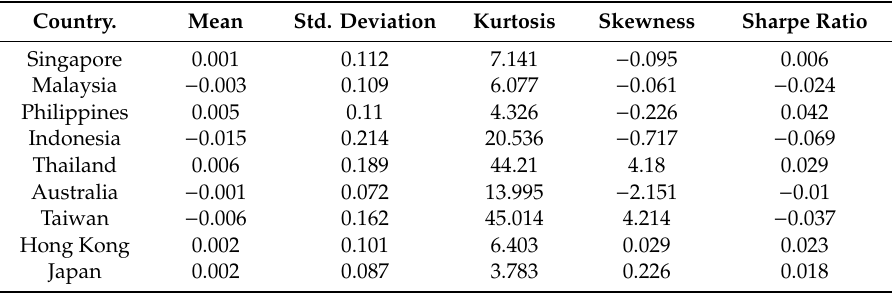
Table 1. Statistics of monthly real estate excess returns in APAC markets: 1 / 1998–4 / 2007. Country. Mean Std. Deviation Kurtosis Skewness Sharpe Ratio Singapore 0.001 0.112 7.141 − 0.095 0.006